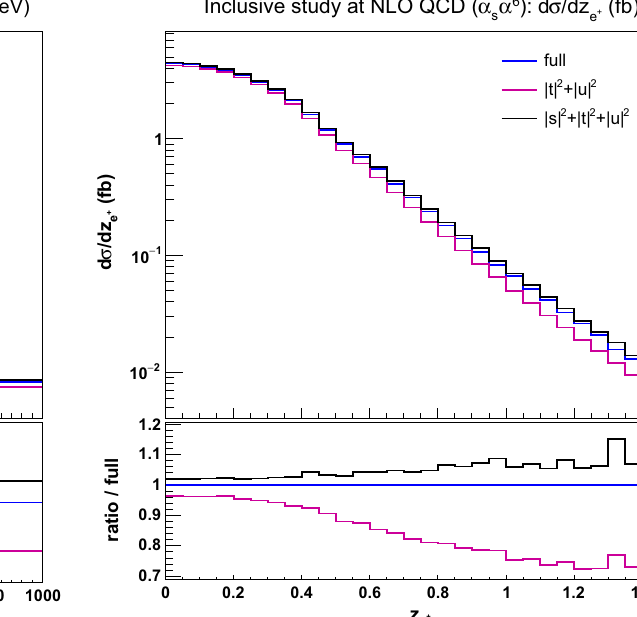
lower plots presents all predictions normalised to MoCaNLO + Recola which is one of the programs that provide the full prediction. In addition to the cuts of Sect. 3.3, the VBS cuts take the values m jj > 200GeV and | Δ y jj | >